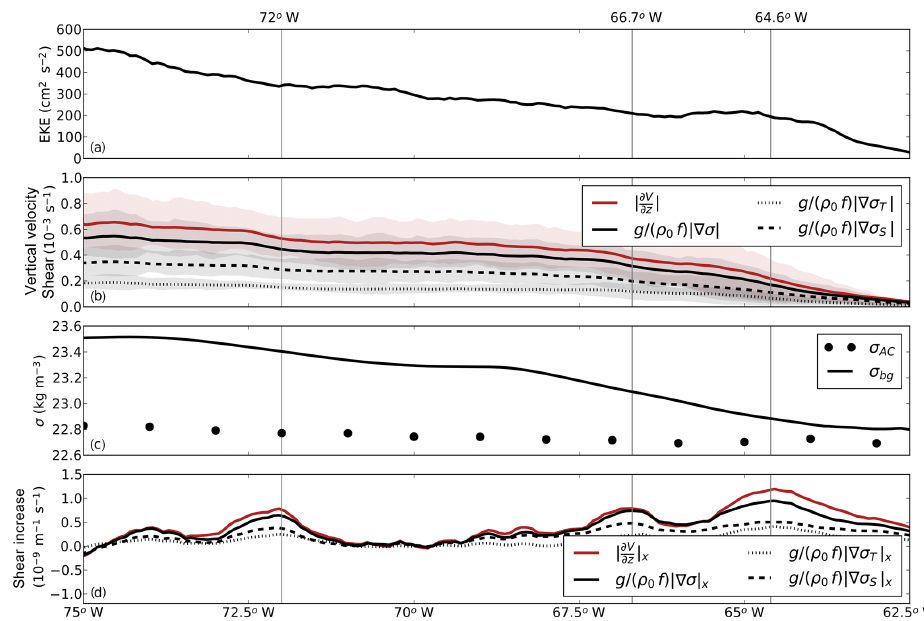
Figure 8. (a) Zonal variation of the (a) meridional maximum eddy kinetic energy, as well as (b) vertical velocity shear and shear computed from horizontal density gradients between 12.5 and 17.5 ◦ N of the anticyclones with long tracks. The shaded regions indicate the 25th and 75th percentile. All properties are averaged over the upper 50m of the water column. (c) Density anomaly of the background ( σ bg ) and anticyclones ( σ AC ) averaged over the upper 50m. The density anomaly of the anticyclones is averaged per degree longitude. (d) The variations of vertical shear and horizontal density gradients with longitude in the westward direction of the anticyclones with long